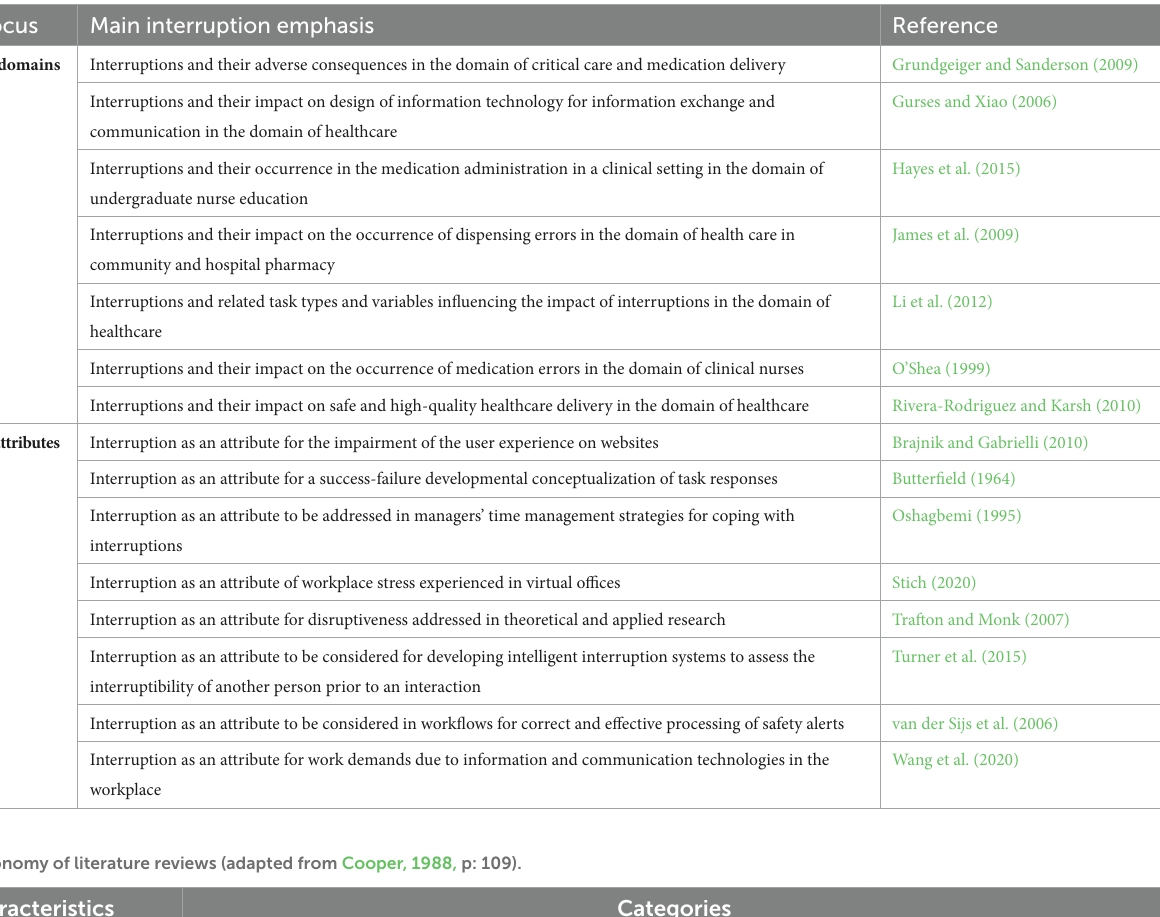
TABLE 1 Identified reviews on interruptions with their corresponding